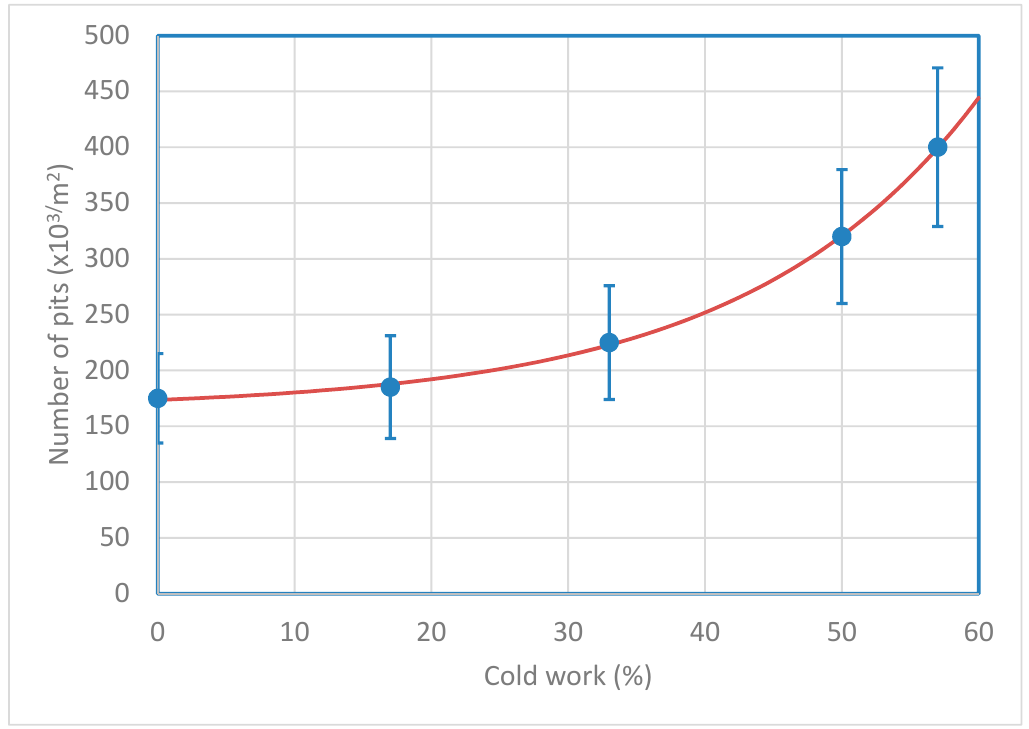
Figure 11. Graphical representation of the correlation between the cold work and number of pits in a 10% mass solution of FeCl 3 ·6H 2 O.